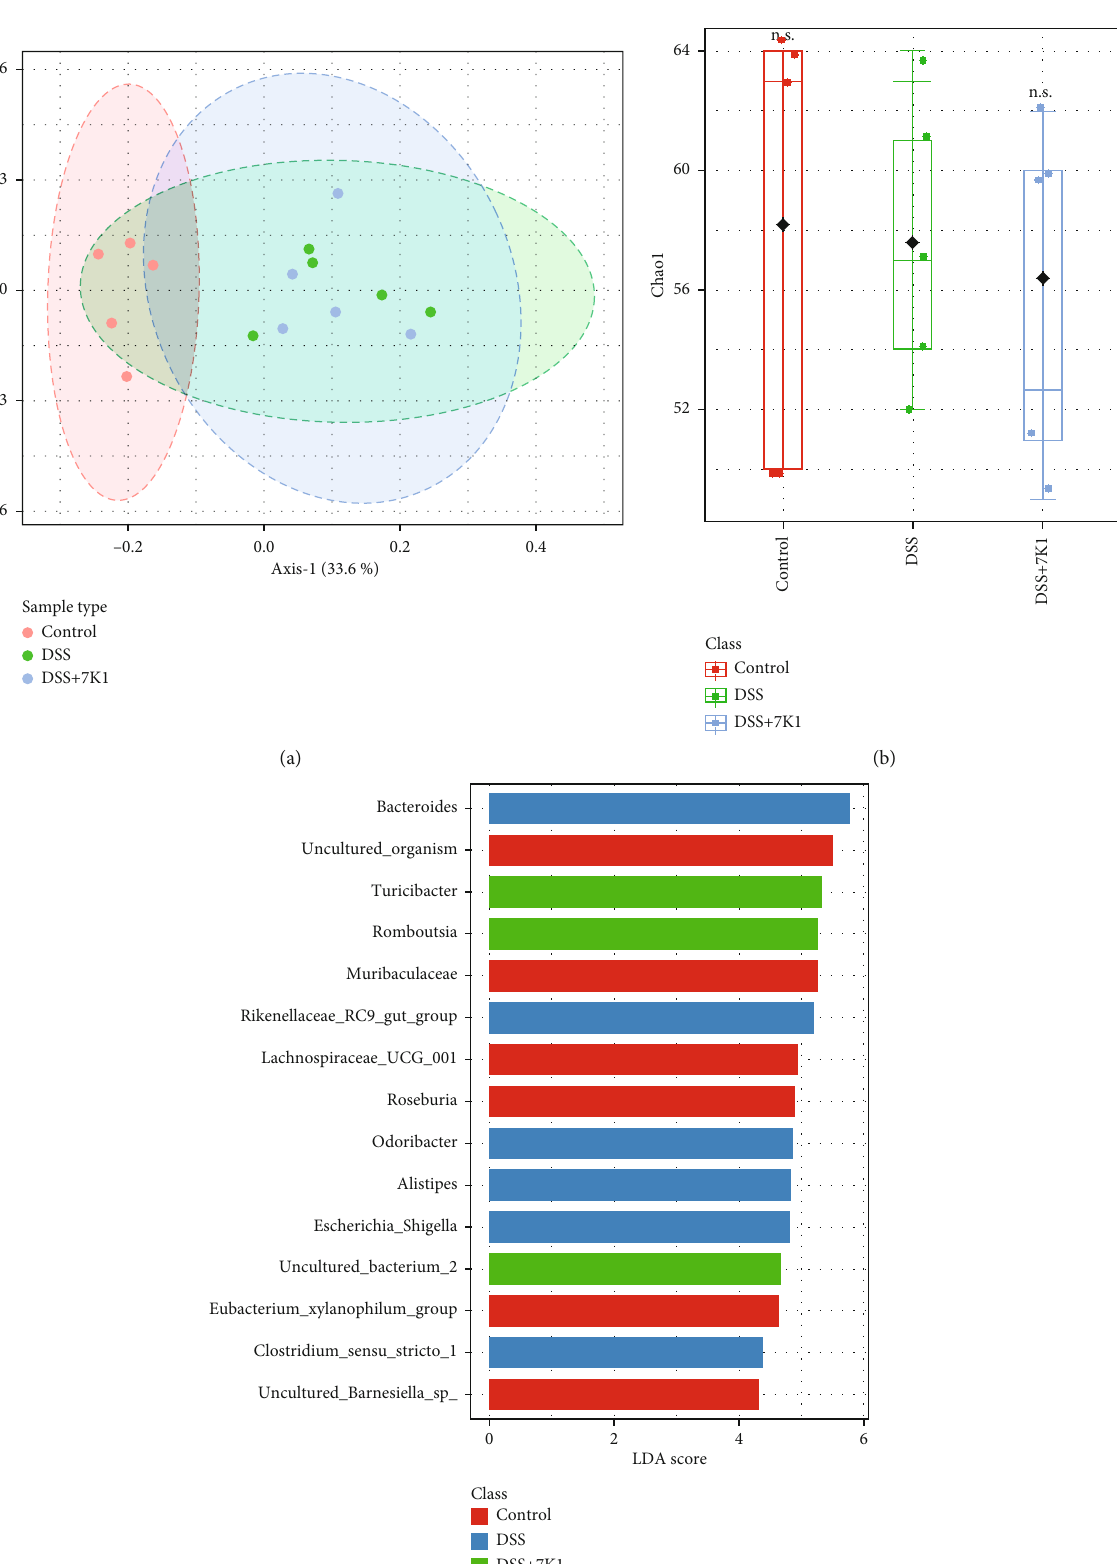
Figure 8: E ff ect of Bacteroides vulgatus on the intestinal microbiota of mice. (a) Principal component analysis of gut microbiota. (b) Alpha diversity indicated by Chao1 index. (c) LEfSe analysis of the di ff erent groups. Five mice per